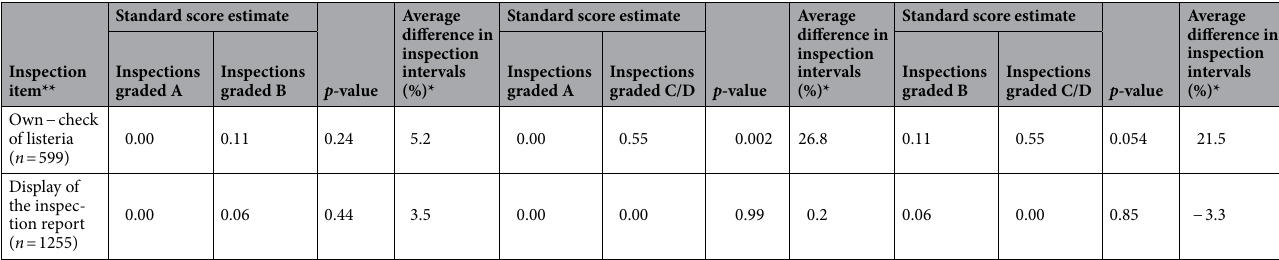
Table 4. Standard score estimates for inspection items at pre-planned inspections resulting in grades A, B, and C or D. Estimates were calculated using generalized estimating equations. A higher standard score estimate denotes a longer inspection interval. *Calculated as difference between standard score estimates multiplied by mean standard deviation divided by mean inspection interval. **Inspection items with n > 1000 included. In addition, inspection items with statistically significant findings and 500 > n > 1000